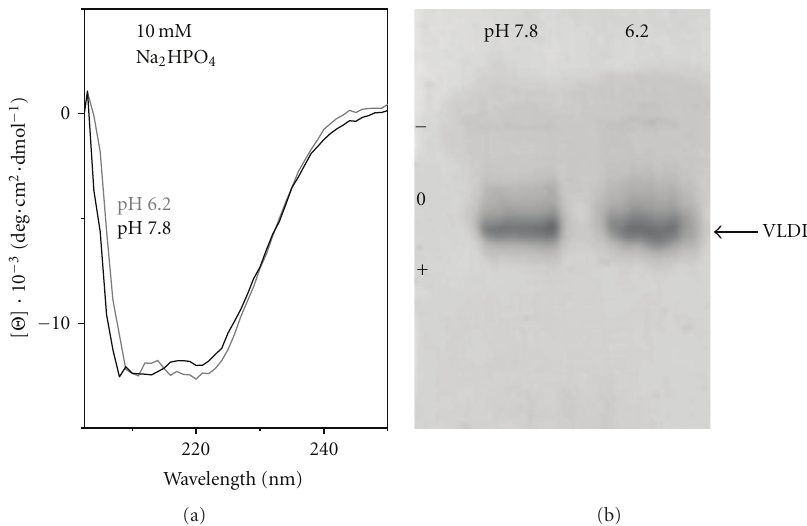
Figure 2: Change from mildly basic to mildly acidic conditions does not a ff ect the protein conformation or the net change on VLDL. VLDL solutions in 10mM Na phosphate bu ff er at pH 6.2 or 7.8 were analyzed by far-UV CD spectroscopy for the apolipoprotein secondary structure (a) or by agarose gel electrophoresis for the net charge on the lipoprotein